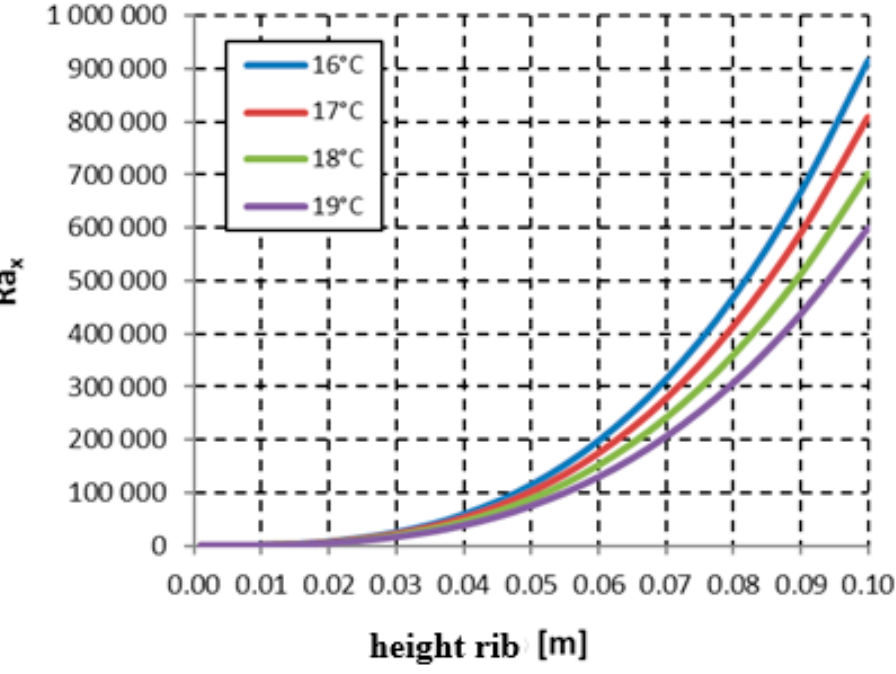
Table 2. Calculated isothermal cooling performance for plates. Figure 12. The dependence of Rayleigh criteria-number on height, at different temperatures for plates.